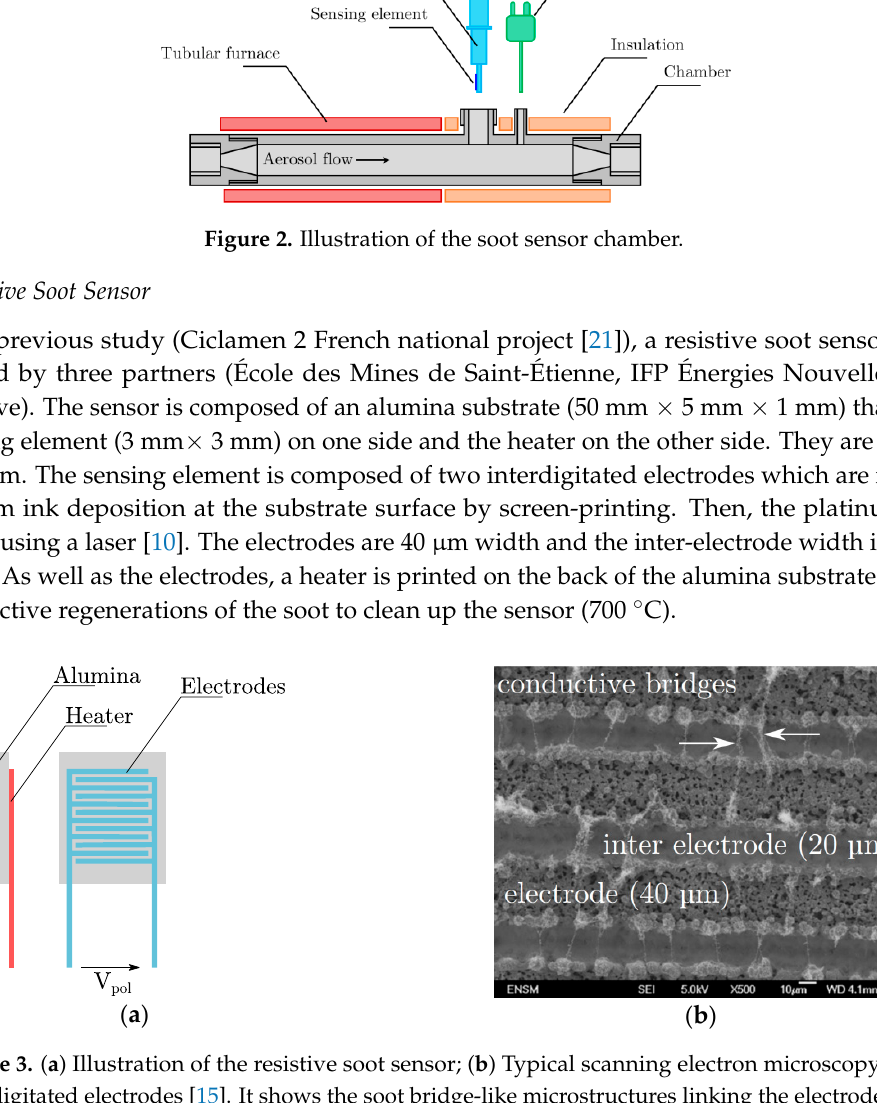
Figure 2. Illustration of the soot sensor chamber.